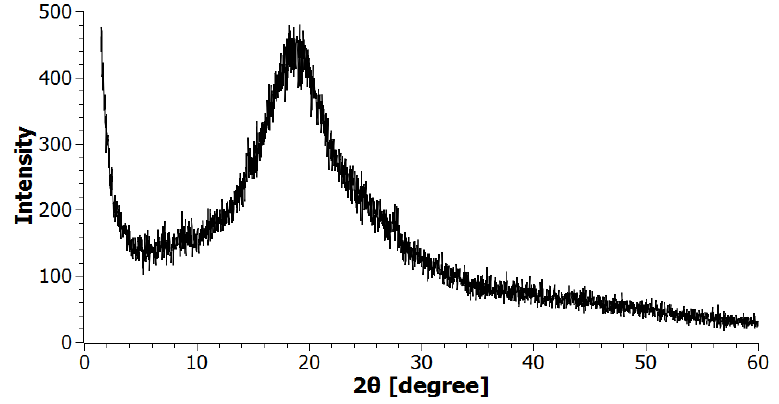
Figure 1. XRD pattern of raw BP.